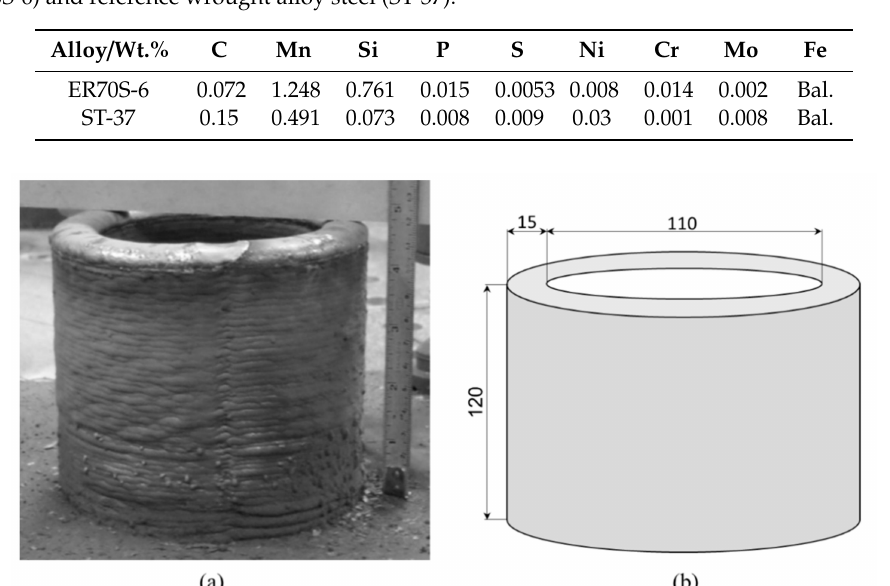
Table 1. Chemical compositions (wt.%) of wire arc additive manufacturing low carbon steel samples (ER70S-6) and reference wrought alloy steel (ST-37).